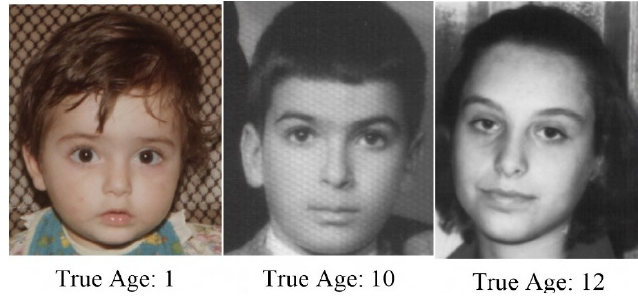
Figure 3. Sample faces from FG-NET.